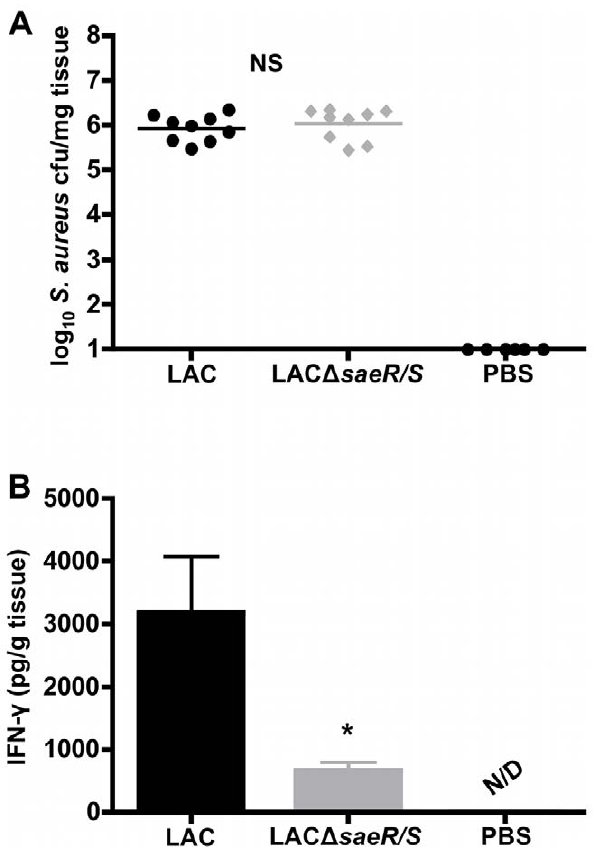
Figure 5. Skin infection with LAC induces IFN- c in a saeR/S - dependent manner. Mice were inoculated subcutaneously with LAC, LAC D saeR/S (1 6 10 7 cfu) or DPBS for 8 hours. Infected tissues were excised and homogenized for bacterial load enumeration and IFN- c concentration measurements. ( A ) Bacterial burden at the site of infection. ( B ) IFN- c concentration (pg/g tissue) in affected tissues. * P , 0.05 compared to MW2 in each panel as determined by t test. Results are from 3 biological replicates of 3 mice/group (n=9) and 2 mice/PBS group (n=6). NS=not significant; N/D=not detectable.